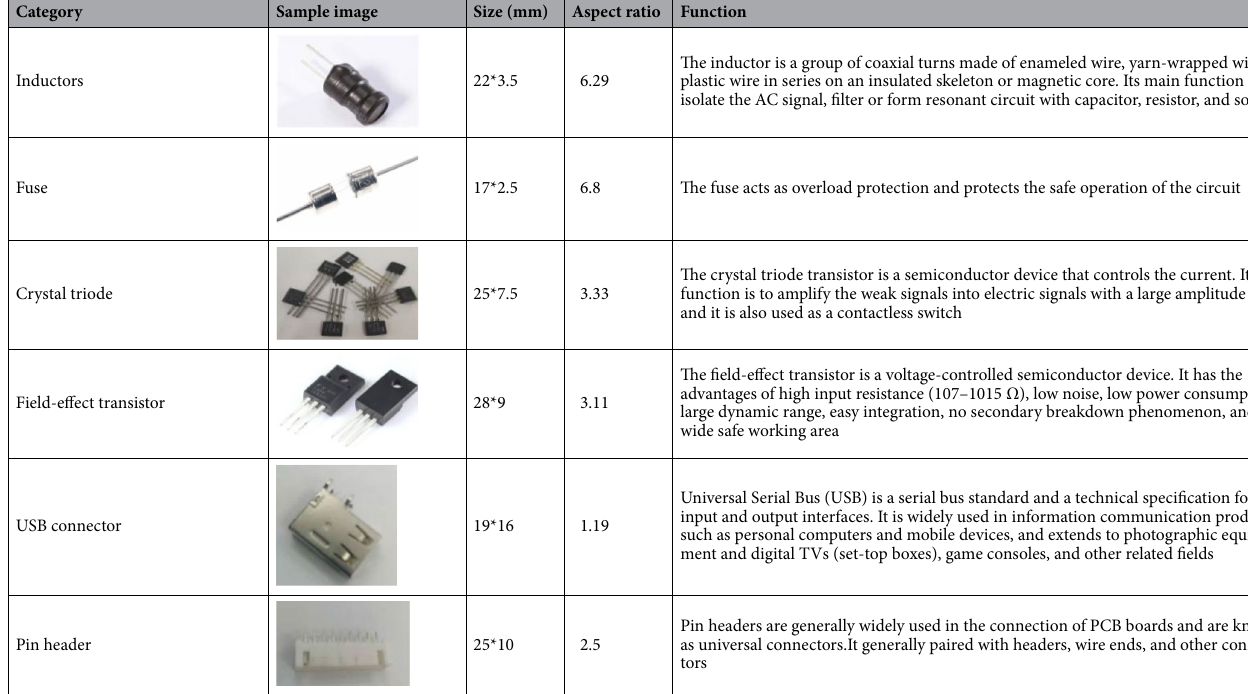
Table 1. Categories and usages of the electronic